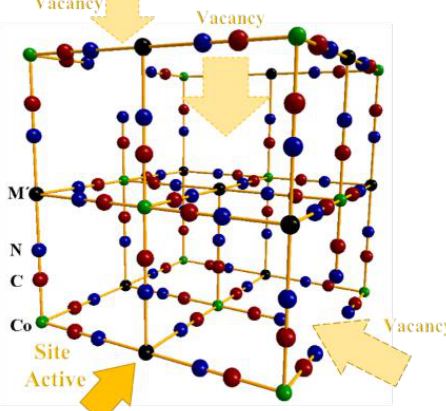
Figure 1. Unit cell for the structure of hexacyanocobaltates M 3 [Co III (CN) 6 ] 2 . where M: Mn, Co, Ni and Cu (black), Co III (green), C (red), and N (blue) atoms, respectively. The vacancies have been represented by the absence of the octahedral block, and the water solvate molecules have been omitted for clarity. (For interpretation of the references to color in this figure legend, the reader referred to the web version of the article.)